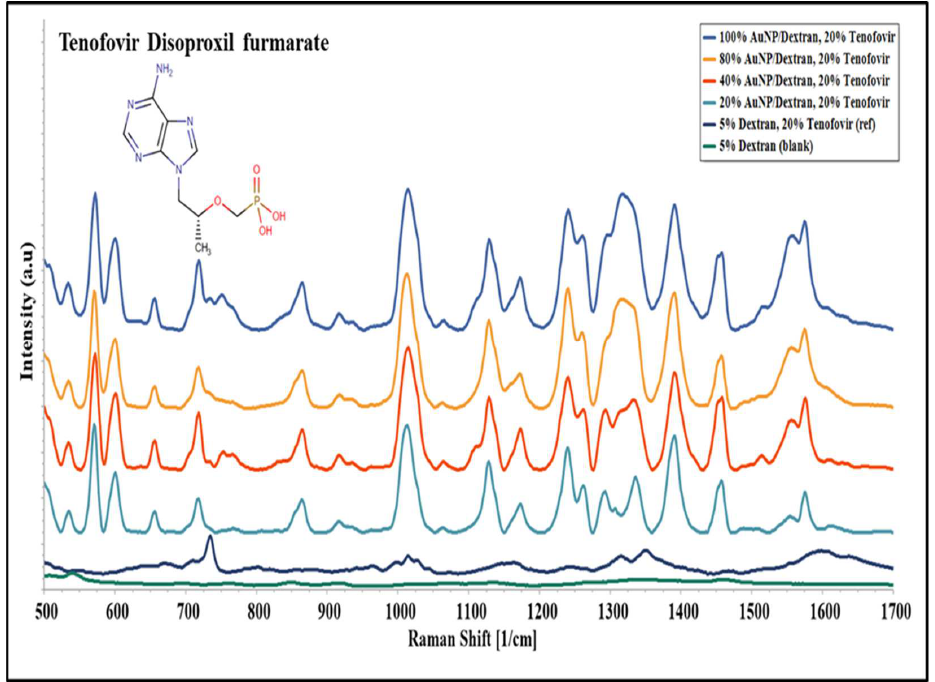
Figure 4. SERS spectra of 20% tenofovir disoproxil fumarate (tenofovir) prepared in Au/dextran NP solutions of 20–100% concentrations; 20% tenofovir in 5% dextran was used as a reference, and 5% dextran solution was used as a blank. Spectra were acquired on BW Tek Raman microscope.